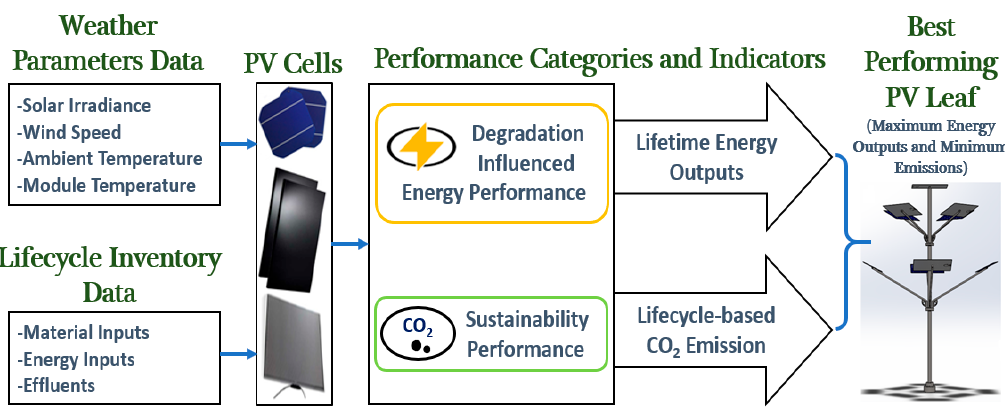
Figure 4. A framework based on a performance prioritization approach for selecting the photovoltaic leaf with maximum lifetime energy outputs and minimum lifetime emissions.